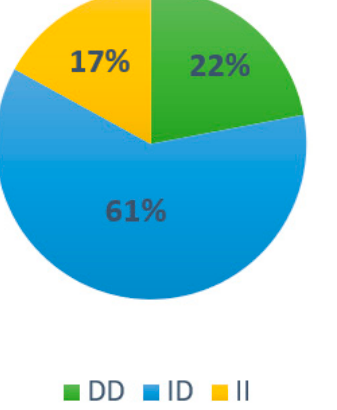
Figure 2. Genotype distribution of the ACE gene in the study population.